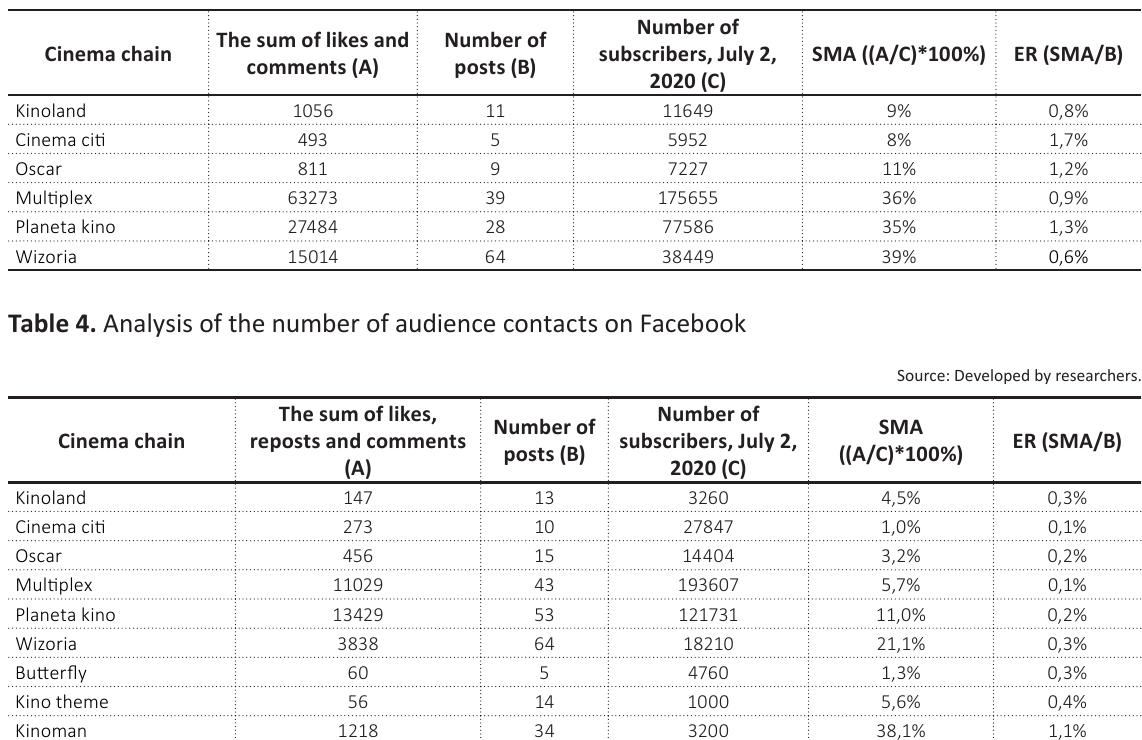
Table 3. Analysis of the number of audience contacts on Instagram